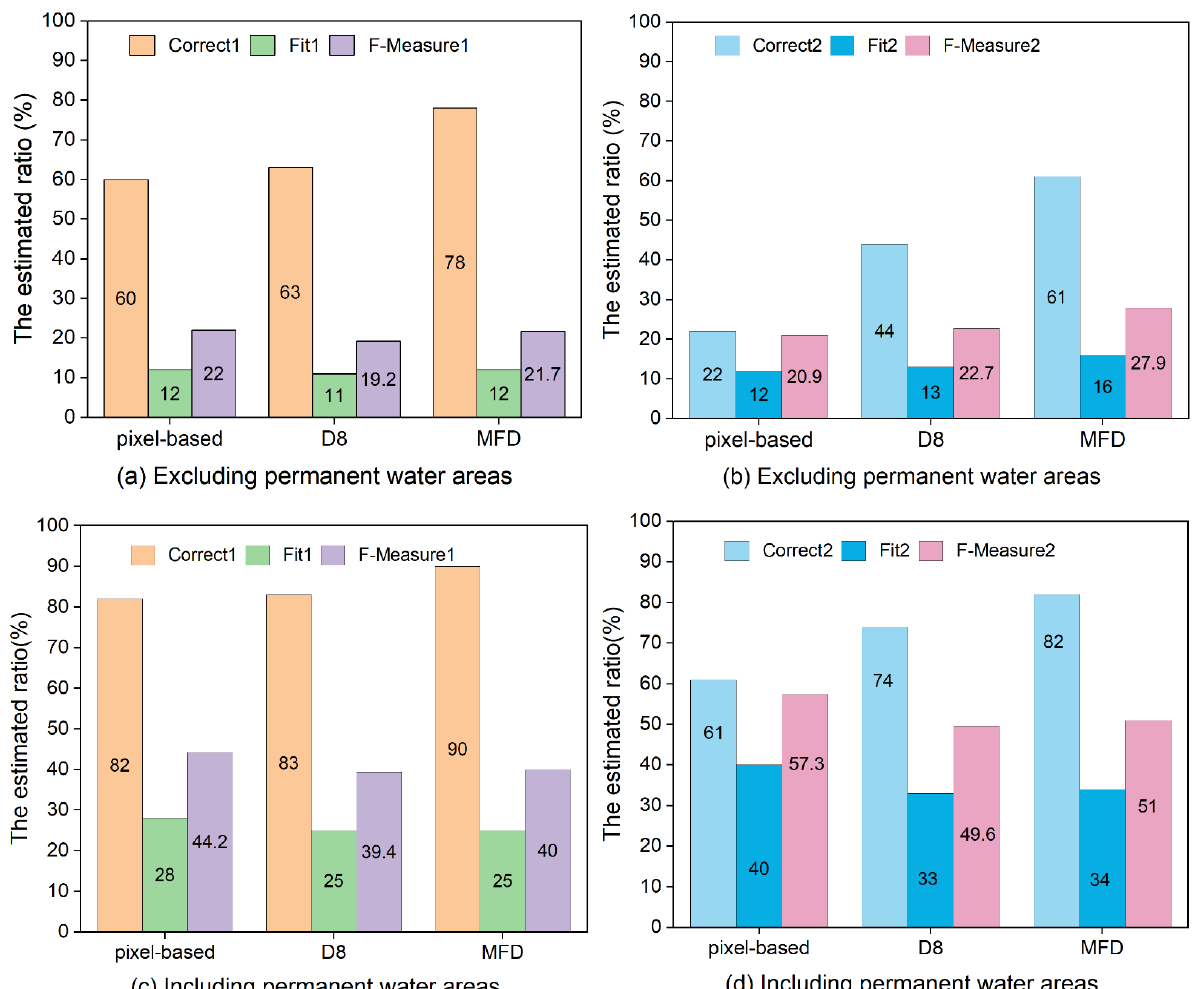
Figure 15. The correct ratio, fit ratio and F-measure basing the validation dataset excluding permanent water areas and including permanent water areas. ( a , b ) were the validation ratio using floodwater areas excluding permanent water areas. In contrast, ( c , d ) was the validation ratio using all water areas on flood days.